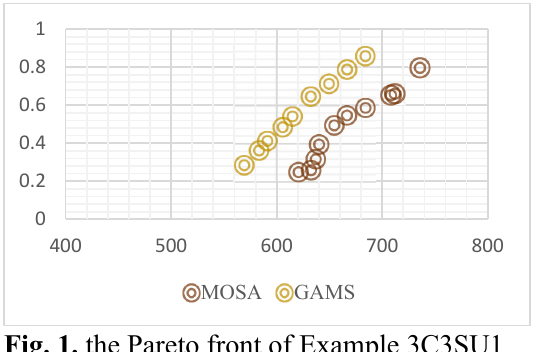
Fig. 1. the Pareto front of Example 3C3SU1 Fig. 2. the Pareto front of Example 3C3SU2